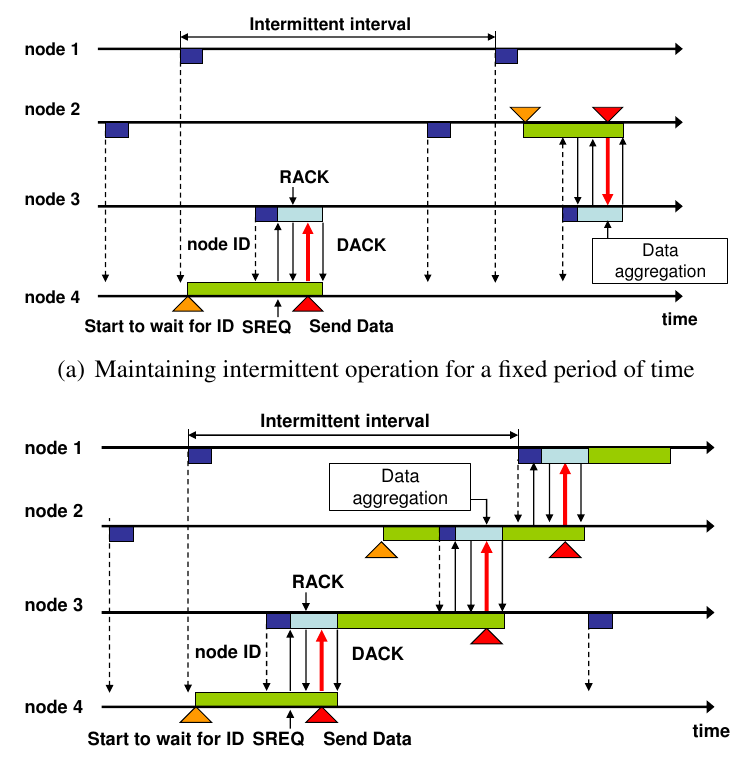
Figure 10. Data aggregation procedures in